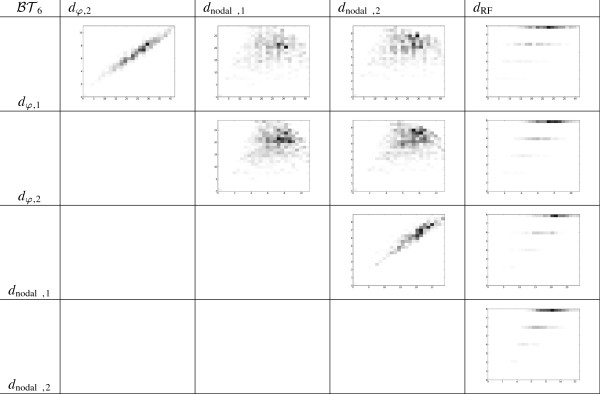
2D-histograms showing the relationship between different distances onBT6.